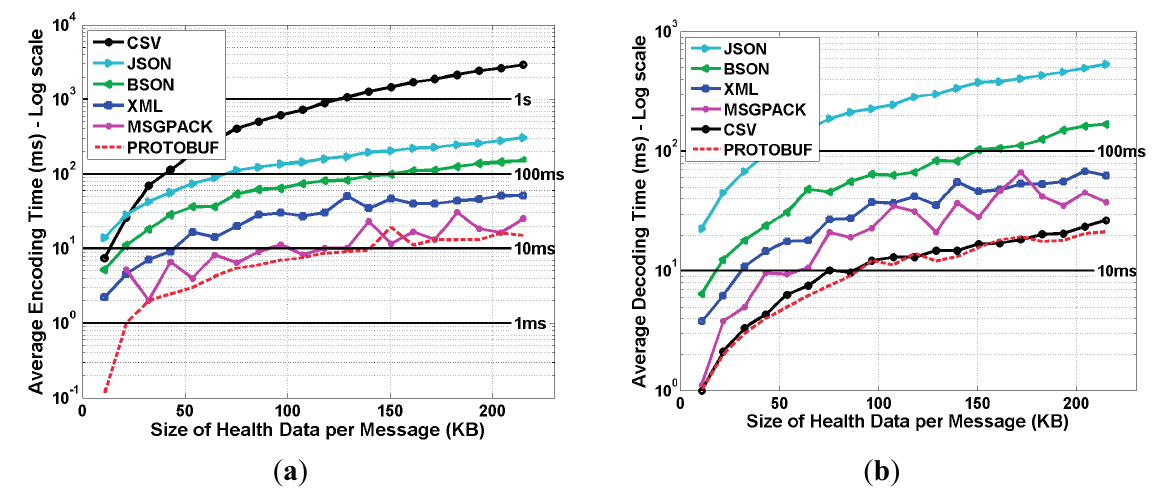
Figure 7. Performance of the Data Serialization Formats—Encoding and Decoding Times (All data serialization formats were implemented in C# and evaluated on an Intel Core machine with 2.70 GHz CPU and 2 GB memory). ( a ) Average Encoding Time (ms); ( b ) Average Decoding Time